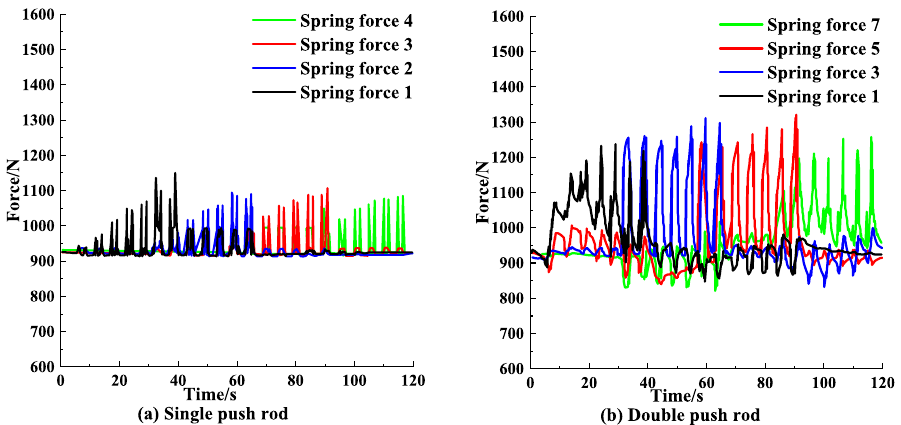
Figure 19. The change of spring force of single push rod support adjustment mechanism, double push rod − double spring support adjustment mechanism when crossing the casing reduction and casing